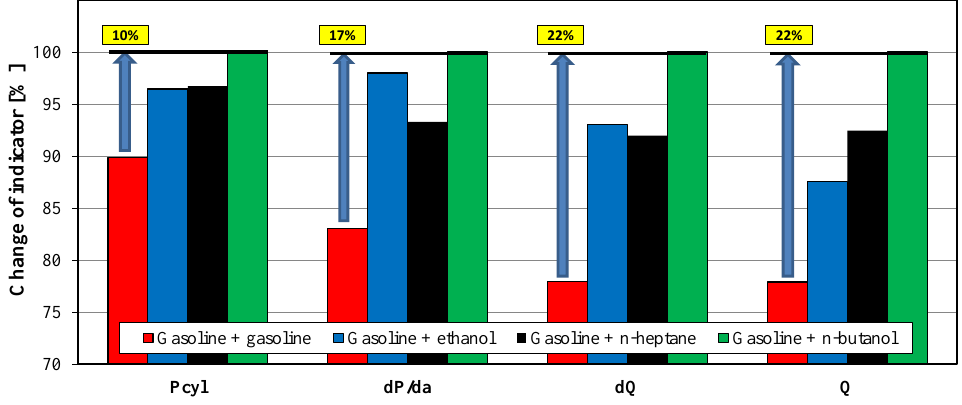
Figure 7. Summary of combustion indicator values when burning gasoline with other fuels.